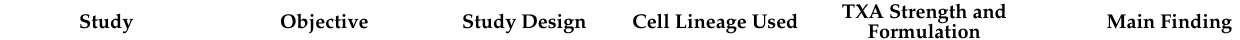
Table 1. Characteristics of included studies—scoping